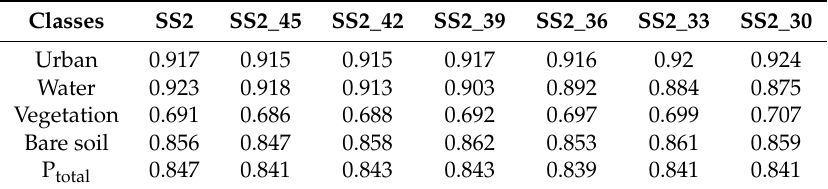
Table 28. Probabilities of correct classification depending on compressed image quality for Set 2, SPIHT coder, ML